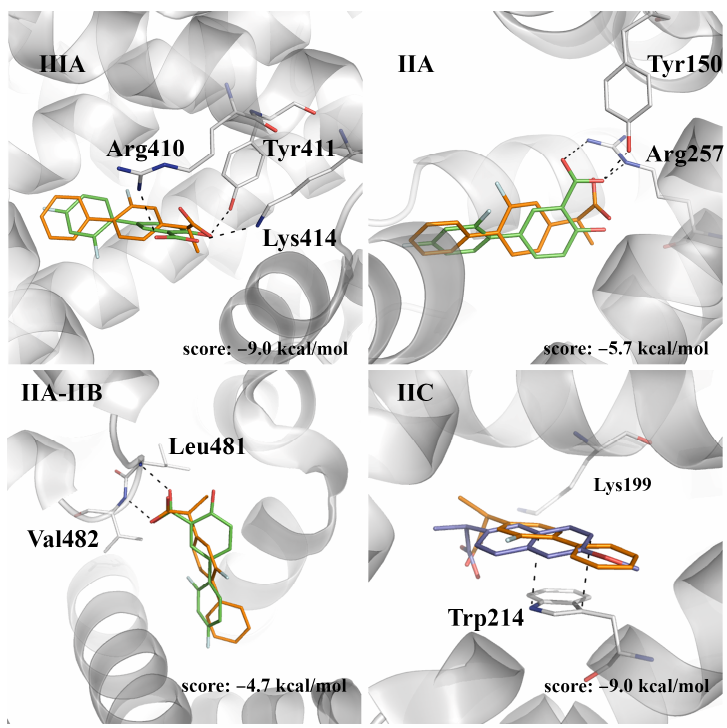
Figure 6. The predicted pose of ( S )-flurbiprofen bound to sites IIIA, IIA, IIA-IIB, and IIC. The crystallographic poses of diflunisal (bound at sites IIIA, IIA, and IIA-IIB; PDB entry 2BXE), and ( S )-naproxen (bound at site IIC; PDB entry 4OR0) are shown as sticks (C atoms in green and dark blue, respectively). The docked pose of ( S )-flurbiprofen is shown with C atoms as orange sticks. The protein backbone is displayed as a gray cartoon. Selected interactions with HSA residues are represented as dashed lines.